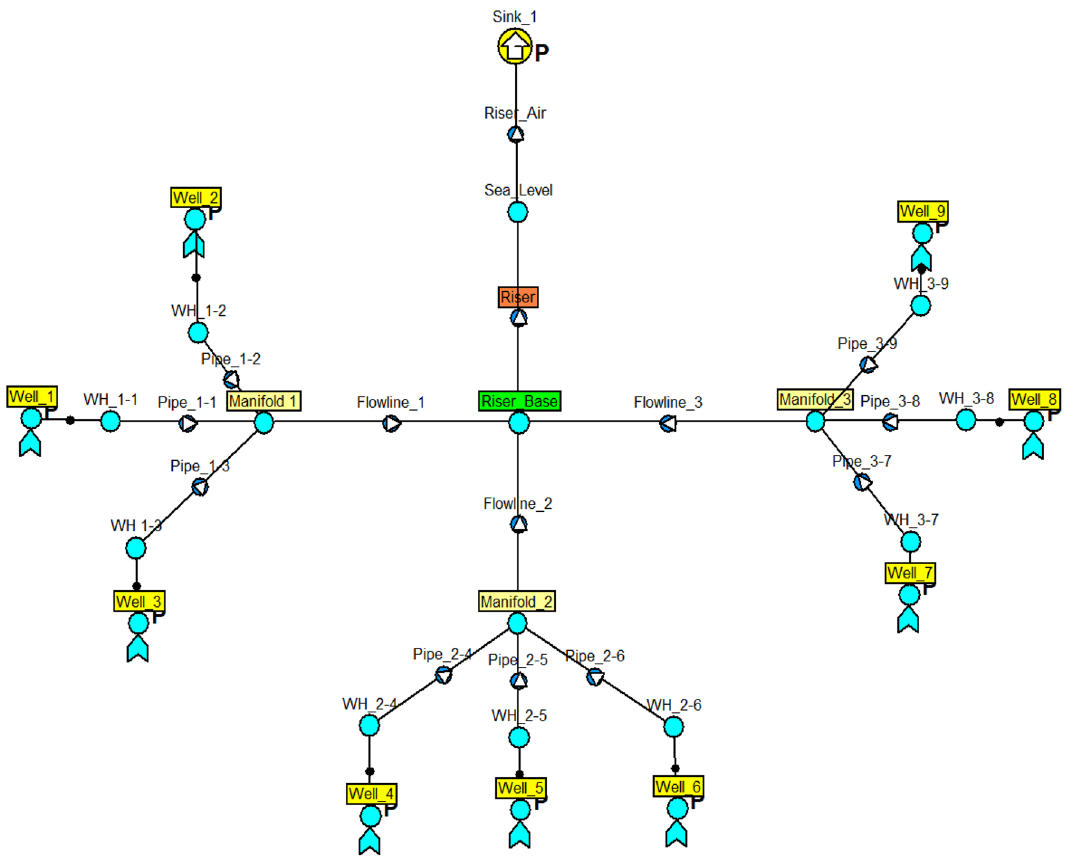
Fig. 2 Production system